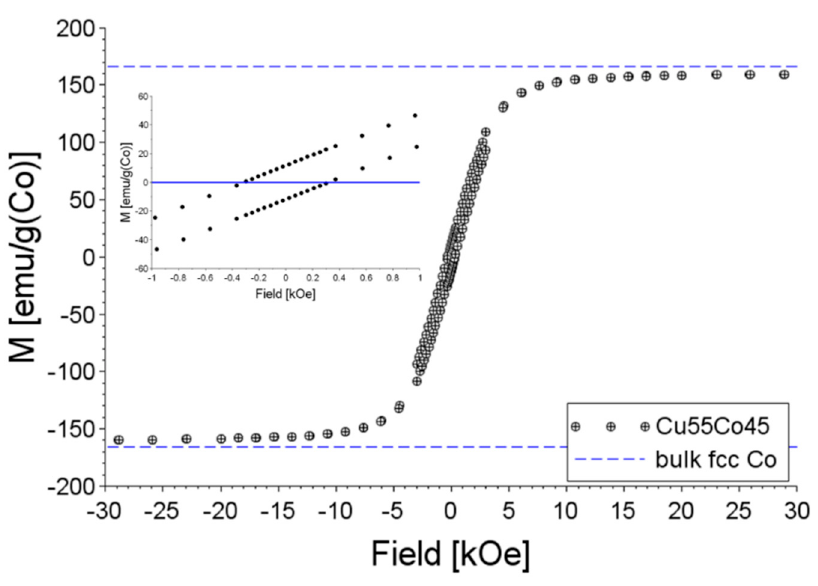
Figure 11. Hysteresis loop (specific magnetic moment versus applied field) of Cu 55 Co 45 , measured at 300 K, with the inset showing a detailed view for lower applied fields. For comparison, the magnetic moment of fcc-Co (164.8 emu/g [53]), is indicated as a dashed line.